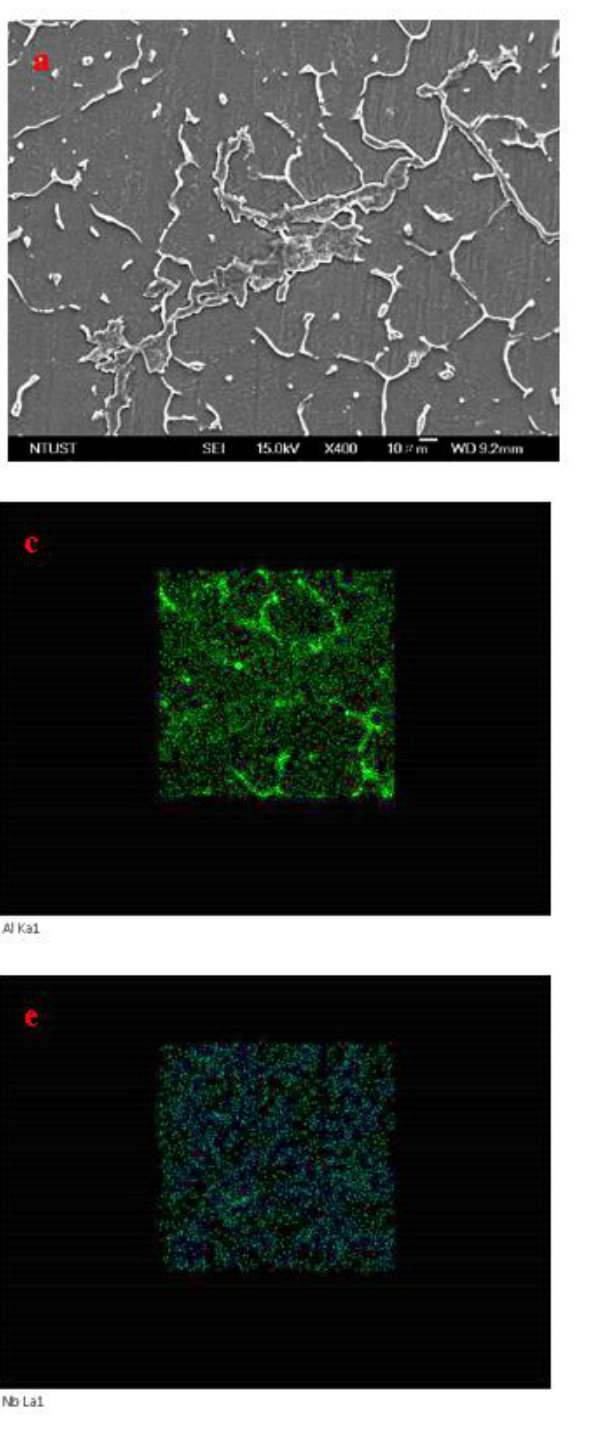
Figure 4. ( a ) SEM image of 6% Nb 2 O 5 + AZ31 microstructure, ( b ) EDS shows Mg distribution, ( c ) EDS shows Al distribution, ( d ) EDS shows Zn distribution, ( e ) EDS shows Nb distribution, ( f ) EDS shows O distribution.